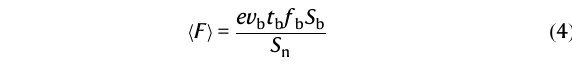
Fig. 6 | Driver of null-point reconnection. a Temporal evolutions of the total magnetic fl uxoftheminorpositivepolaritygeneratingthenull-pointcon fi guration (solid line) and the height of the null-point (dotted line). Two vertical dashed lines represent the start and end times of the HRI EUV observation. b Radial components of the HMI vector magnetograms at three times. The curves in blue show the PILs with the segments in red indicating the locations of BPs. c NVST H α intensity map